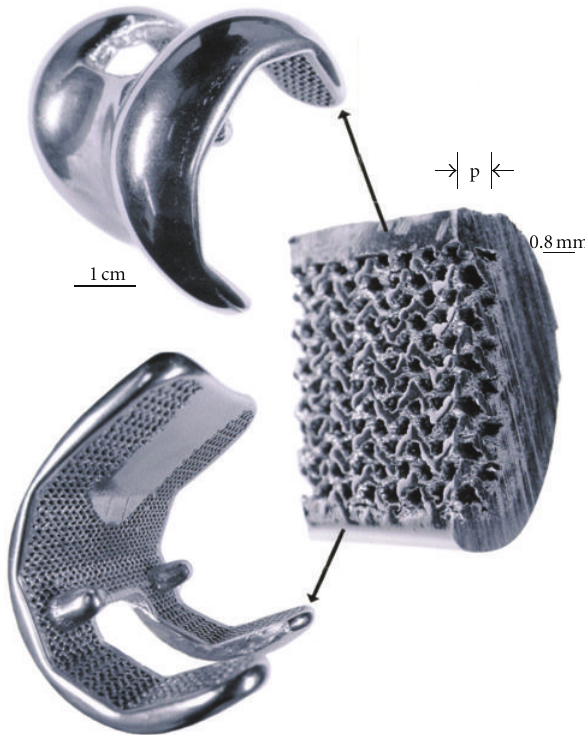
Figure 5: Co-29Cr-6Mo alloy femoral knee implant prototype fabricated by EBM and HIPed according to ASTM-F75 standard. The insert illustrates the porous inner surface zone (p) composing the